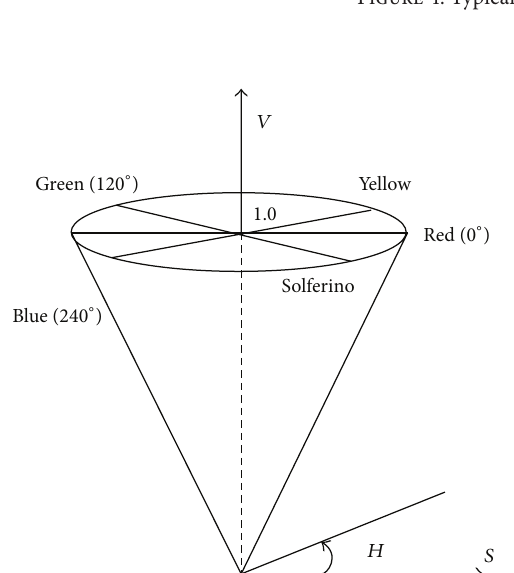
Figure 5: HSI color space